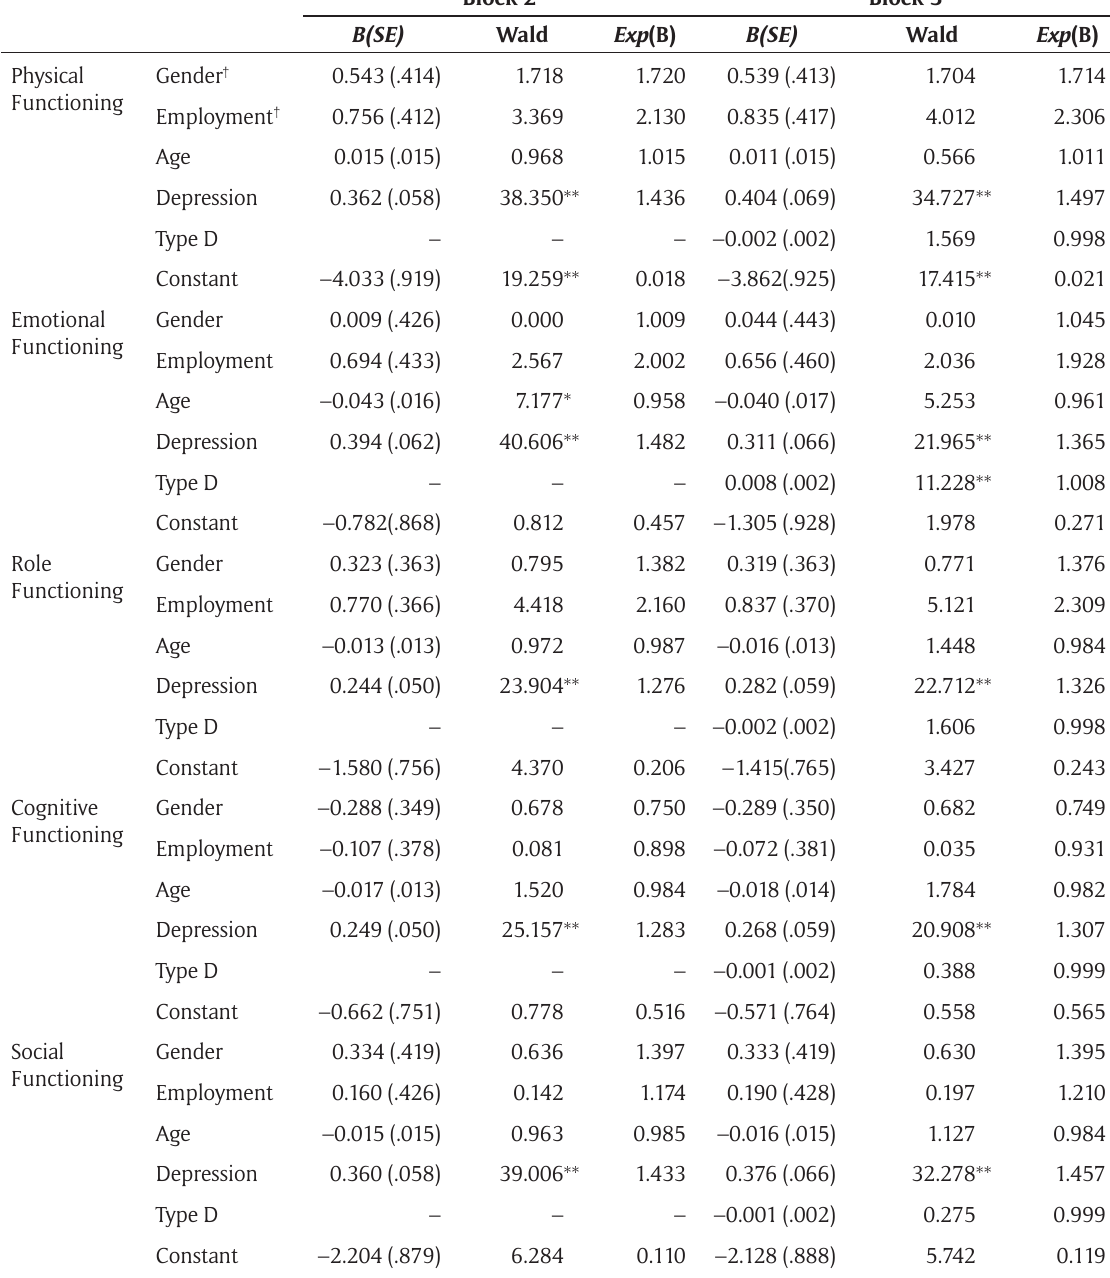
Table 5: Predictor statistic results with depression and Type D as continuous